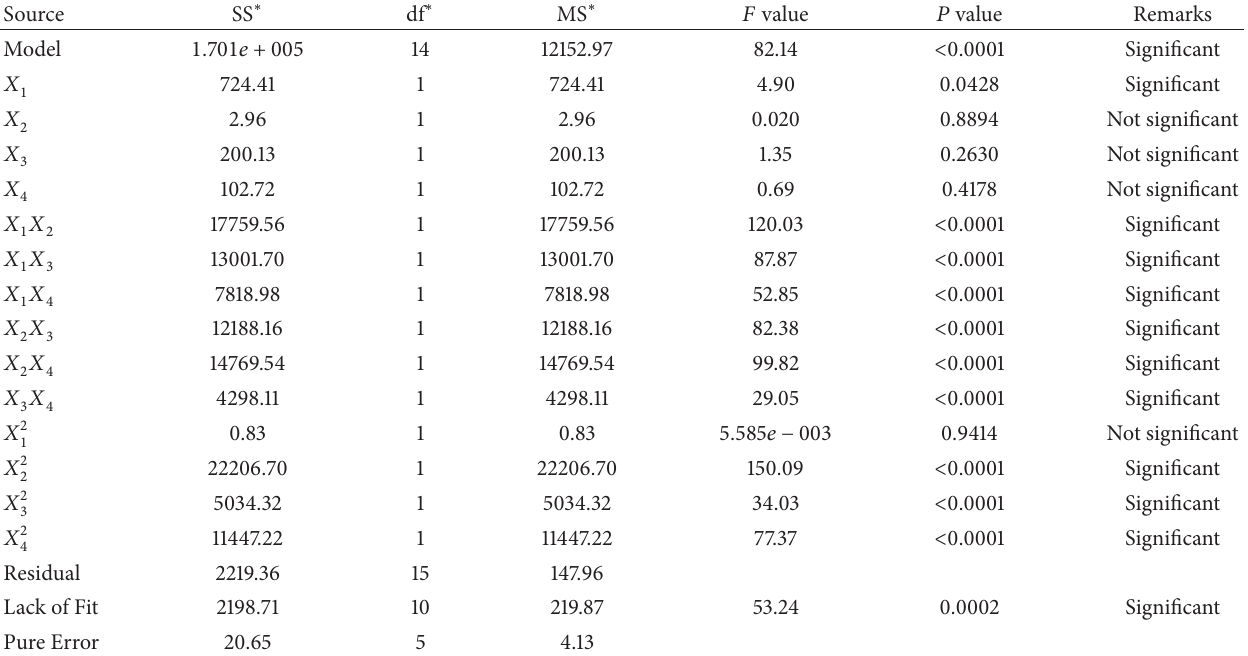
Table 3: Analysis of variance of the fitted quadratic regression model (2).